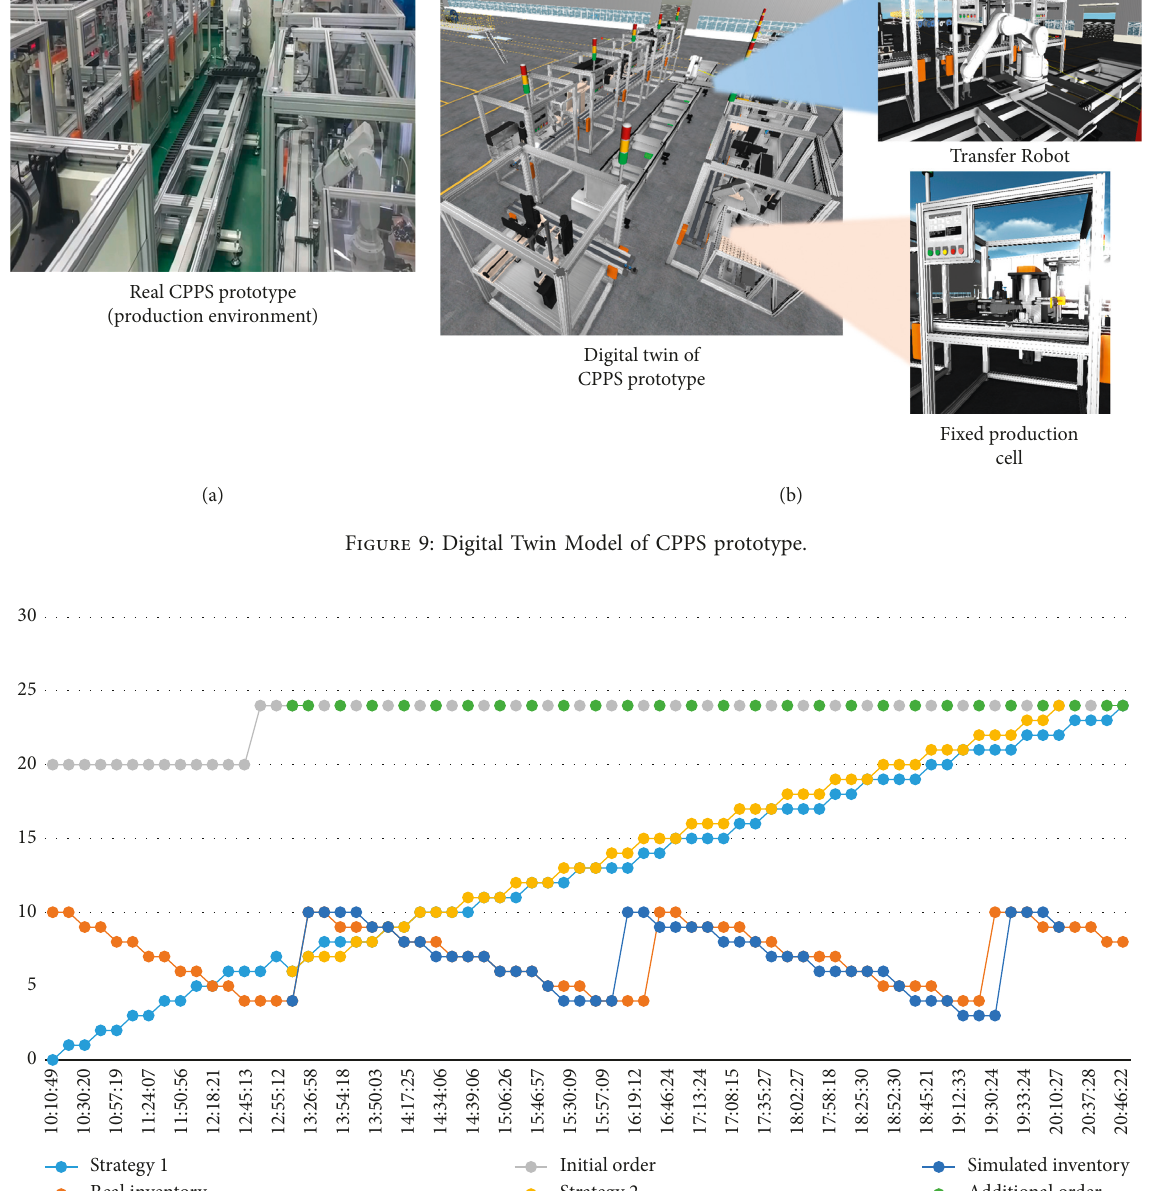
Figure 10: Comparison of simulation results for the completion time of production